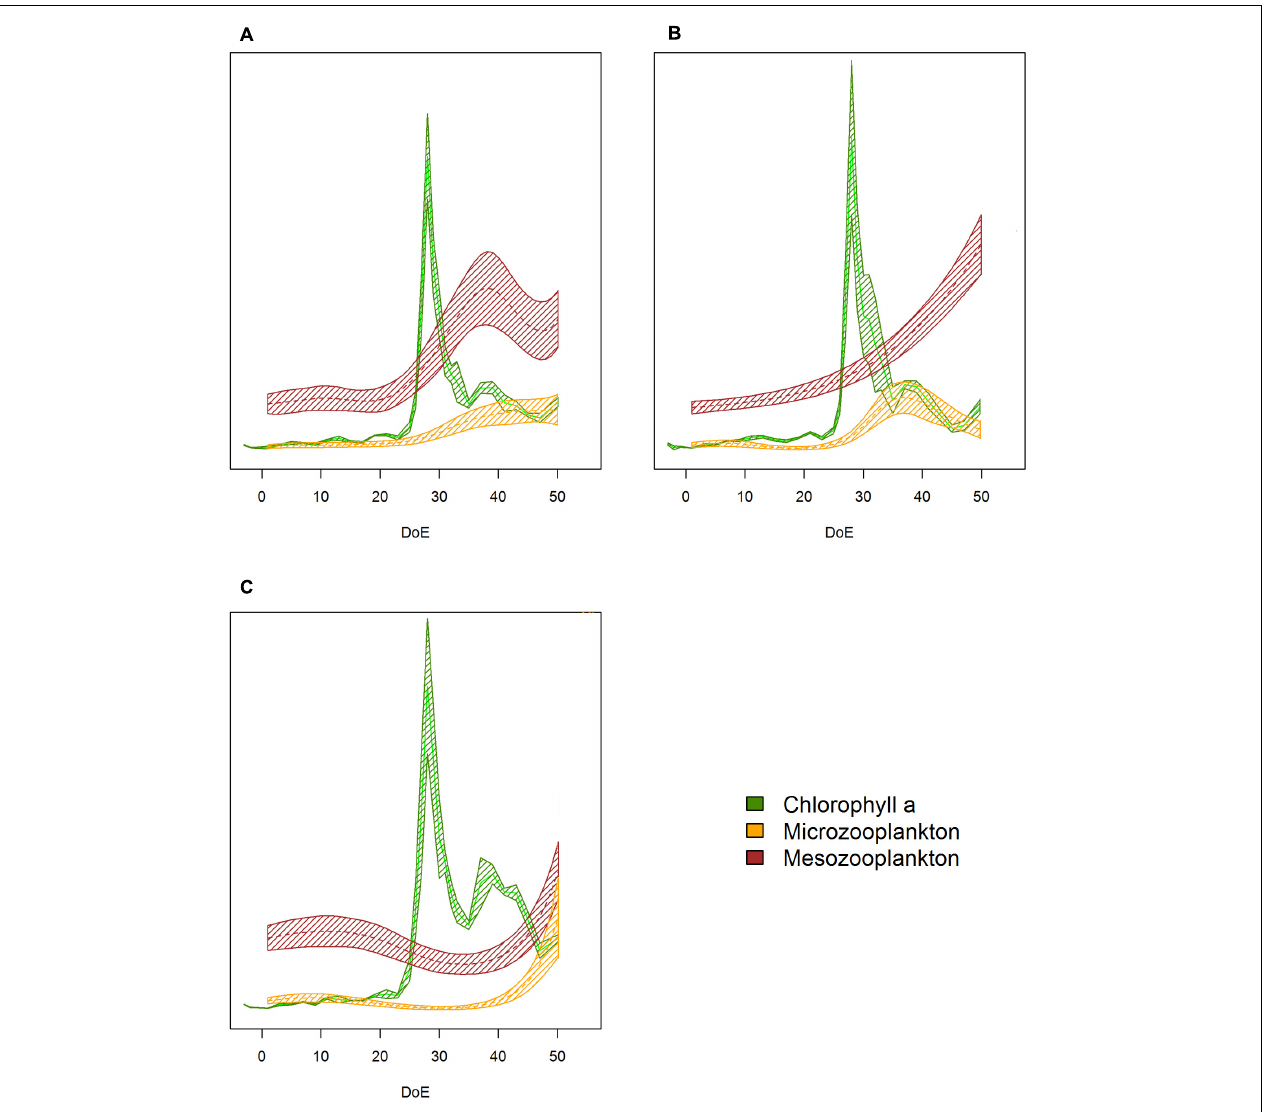
FIGURE 8 | Plankton succession trends. (A) Low- p CO 2 treatment, (B) medium- p CO 2 treatment, (C) high- p CO 2 treatment. Note that trends have been transformed to be in a 0 to 1 scale to enhance plankton succession visibility. Color code: green = Chl a , yellow = microZP abundance, burgundy = mesoZP abundance. DoE, day of experiment. Solid lines = prediction from Generalized Additive Mixed Models (GAMMs) (smoother trends p -value < 0.05); shaded area = confidence